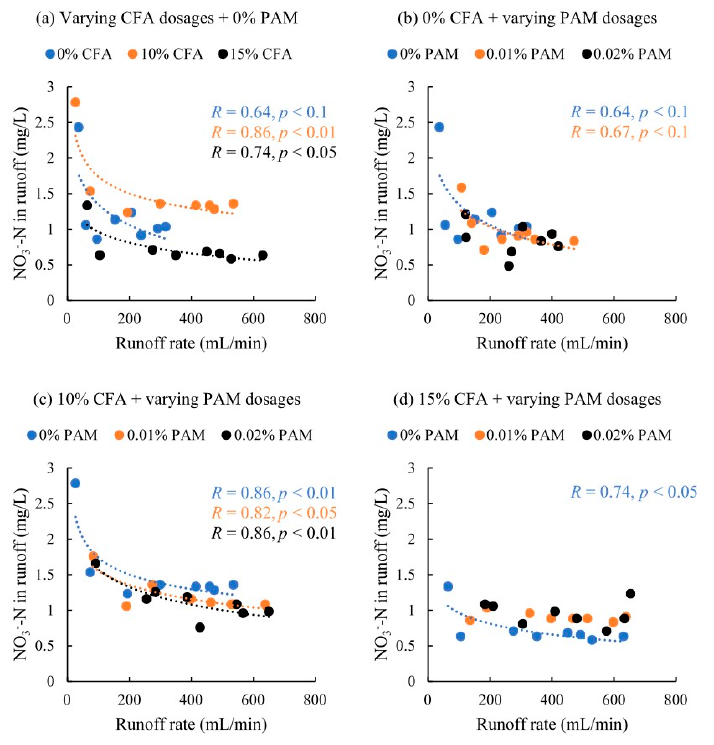
Figure 4. Correlation between NO 3 − -N concentration in runoff and runoff rate for varying CFA dosages + 0% PAM ( a ), 0% CFA + varying PAM dosages ( b ), 10% CFA + varying PAM dosages ( c ), 15% CFA + varying PAM dosages ( d ).